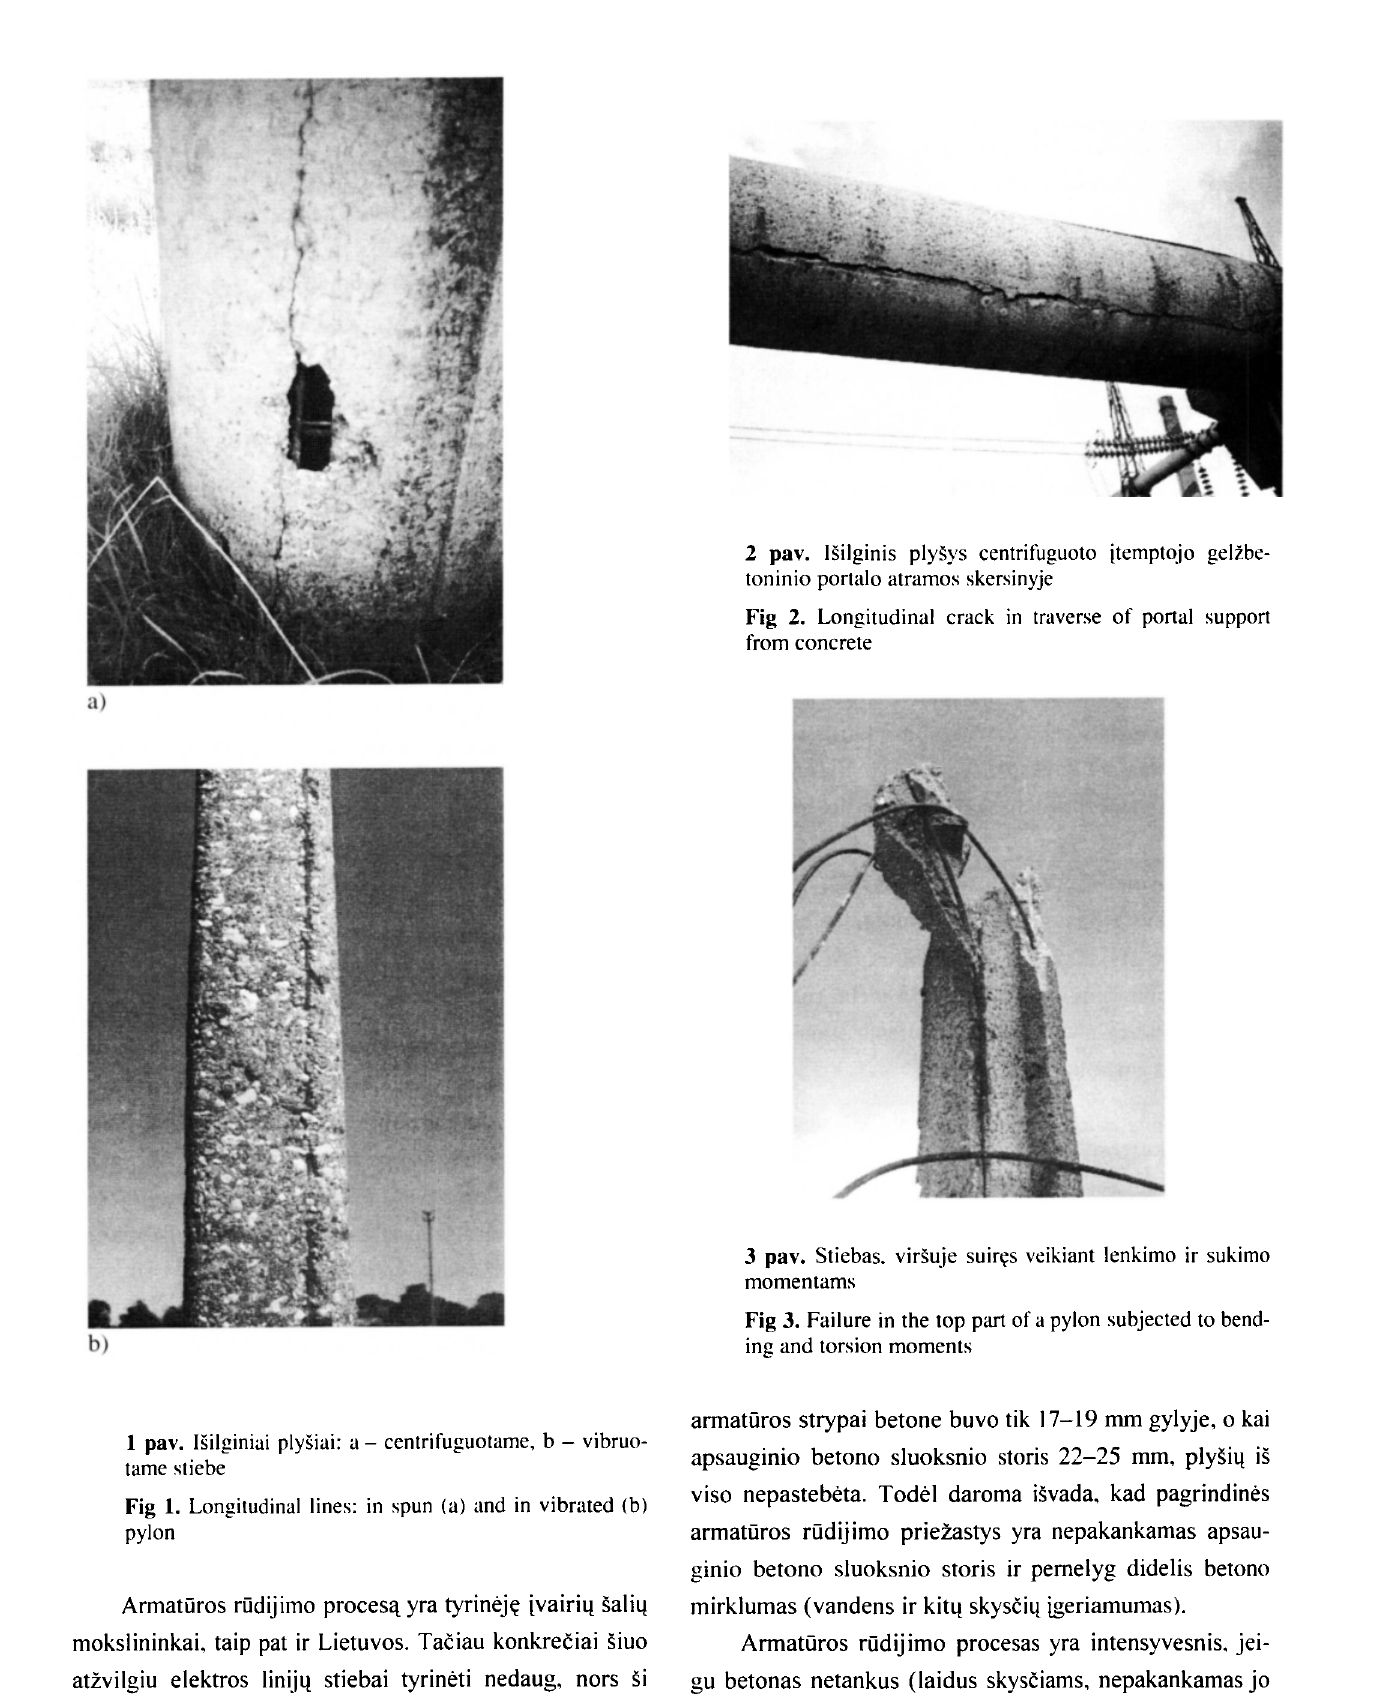
Fig 3. Failure in the top part of a pylon subjected to bend ing and torsion